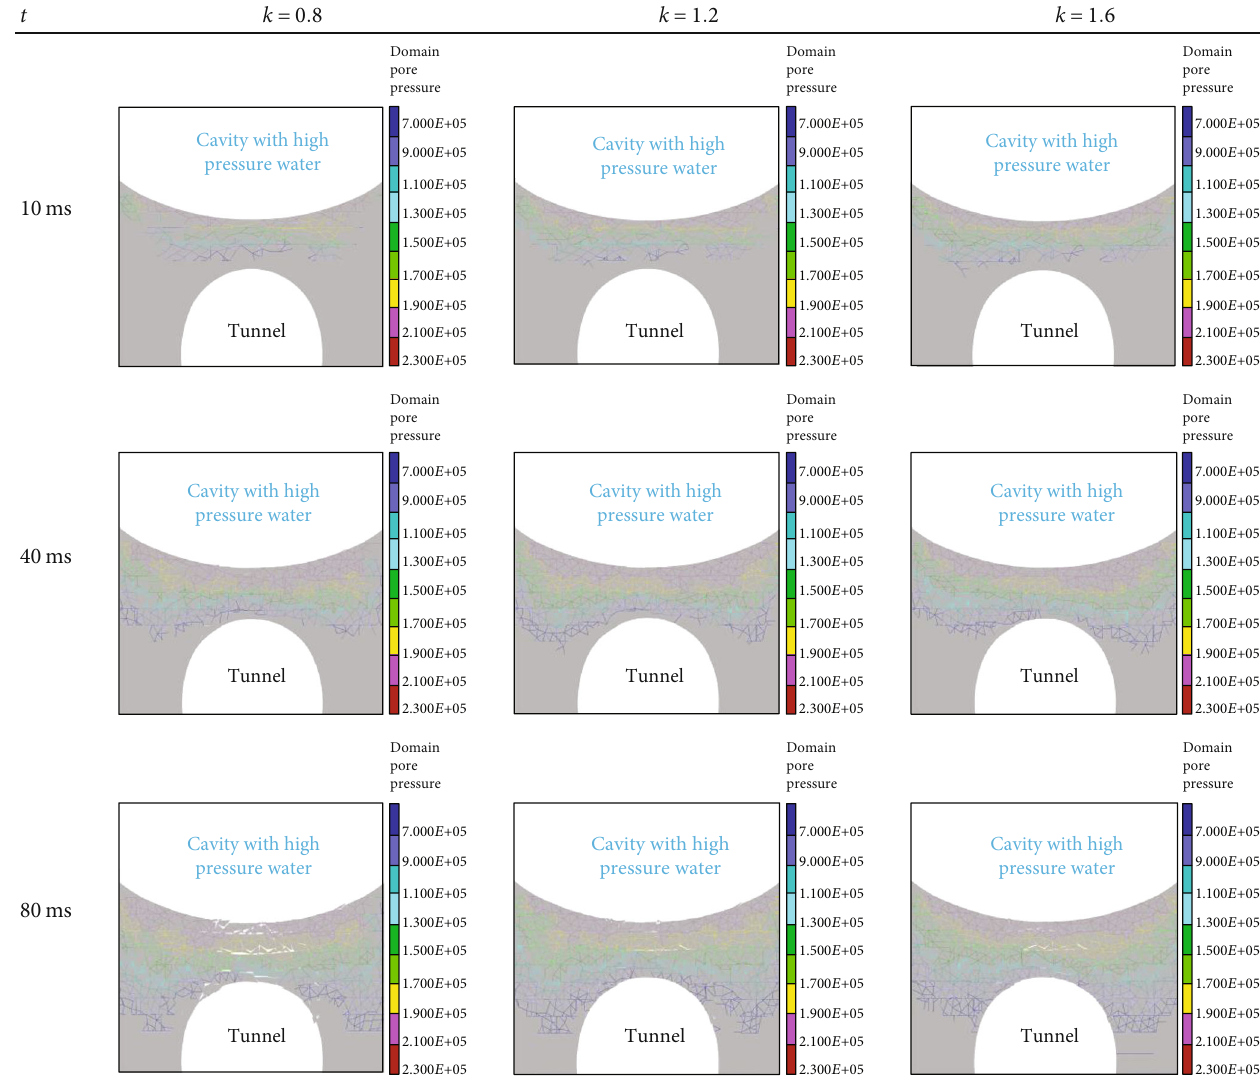
Table 8: The seepage pressure distribution in the water-resistant strata under the three cases of k = 0 : 8 , 1.2, and 1.6 at t = 10 , 40, and 80ms. t k = 0 : 8 k = 1 : 2 k = 1 : 6